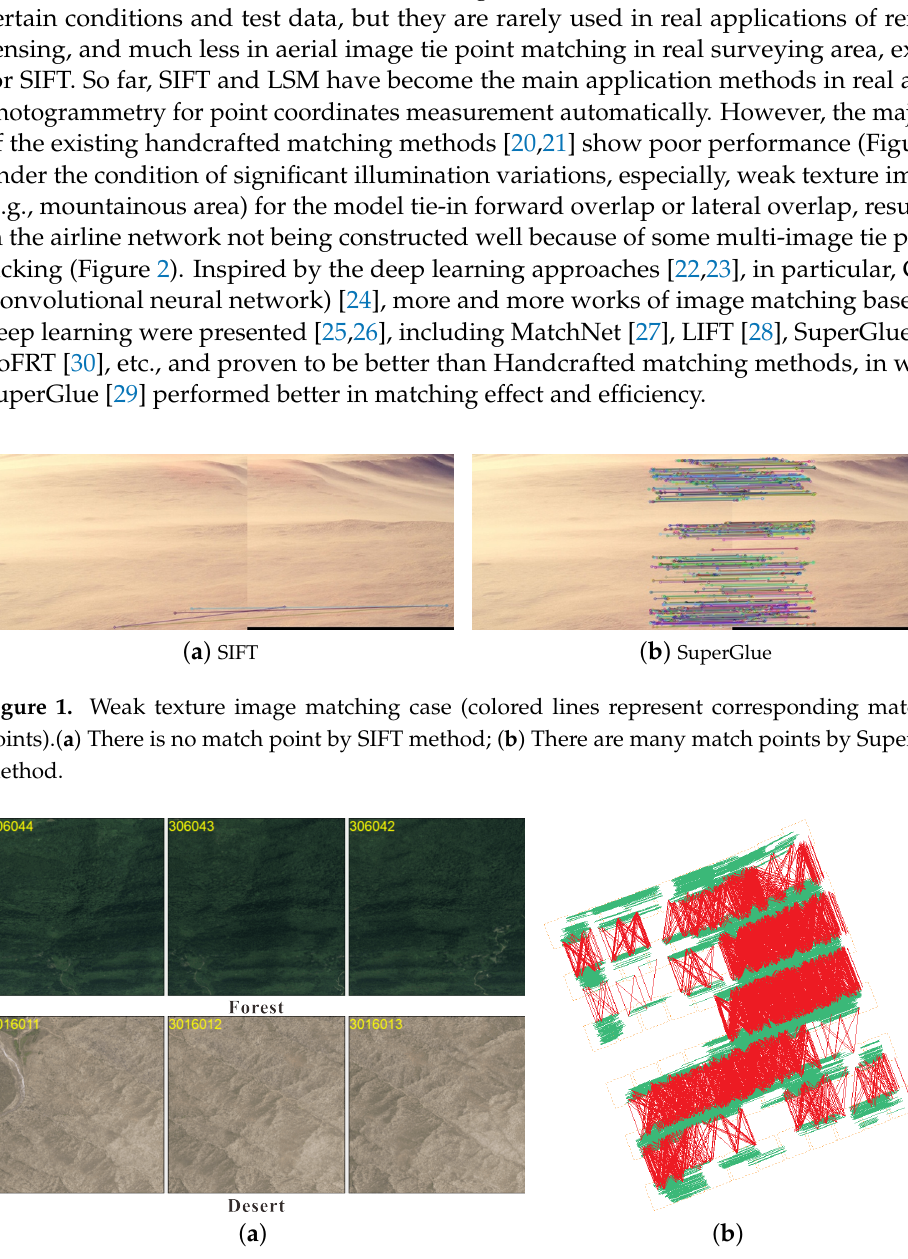
Figure 2. Special texture images and image tie points by Block-SIFT. ( a ) Special texture images; ( b ) Image tie points by Block-SIFT. Green lines are forward image tie lines (no model tie points between a few models), red lines are lateral image tie lines (some images have no image tie points between